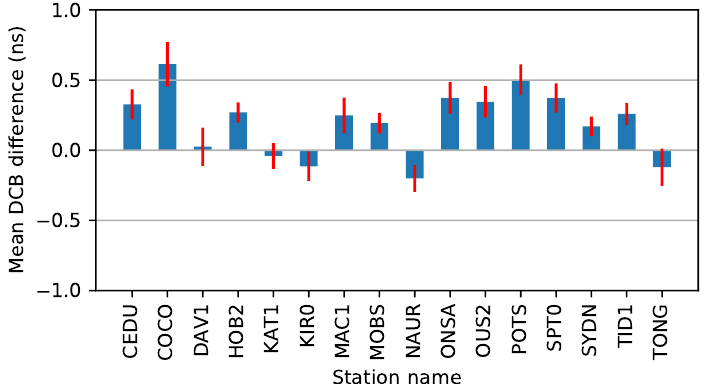
Figure 3. Mean of the DCB difference from the CODE values in May 2018. The mean bias and STD of the DCB differences are in blue and red colors. The average of the mean and STD values is 0.2 and 0.1 ns, respectively.